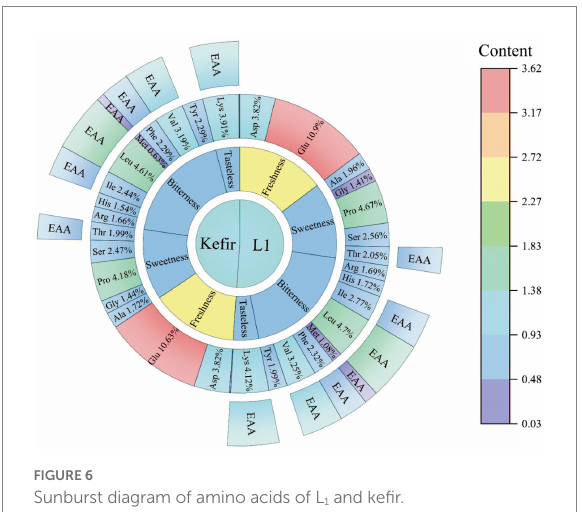
FIGURE 6 Sunburst diagram of amino acids of L 1 and kefir.